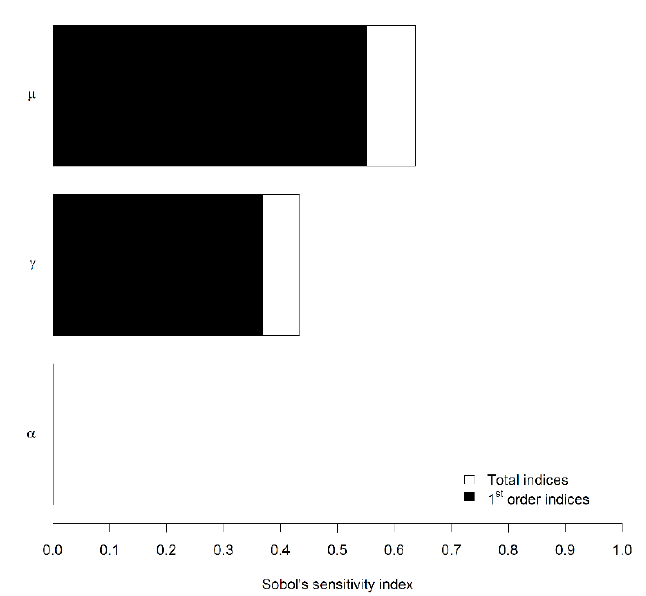
Figure 2. First-order and total Sobol’s sensitivity indices of the three parameters of the logistic equation on the average virus incidence. µ is the abscissa of the inflection point (i.e., the date of the epidemic peak); γ is the plateau (i.e., the carrying capacity); α is related to the slope at the inflection point (i.e., the speed of epidemic around the peak). The first-order index indicates the main influence of a parameter, whereas the total index includes its interactions with other parameters.